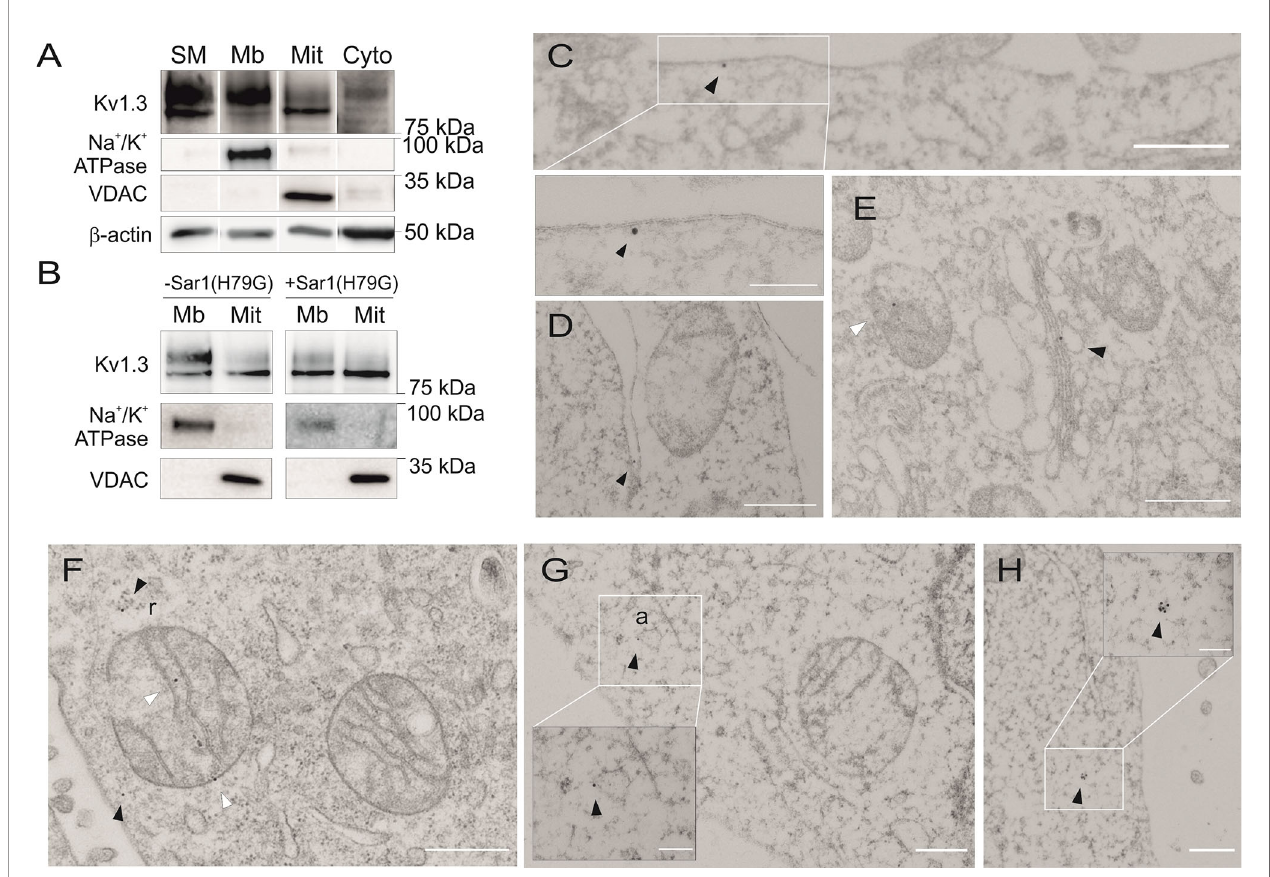
FIGURE 1 | Kv1.3 is targeted to the mitochondria by bypassing the endoplasmic reticulum. (A) Subcellular fractionation to obtain the membranous (Mb), mitochondrial (Mit) and cytosolic (Cyto) fractions of HEK 293 cells transfected with Kv1.3YFP. SM, starting materials. Na + /K + ATPase is used as a plasma membrane (PM) marker, and VDAC is used as a mitochondrial marker. b -actin identi fi ed cytosolic-enriched fractions. Note the difference in molecular weight of Kv1.3 bands from the Mb and Mit fractions. (B) Mb and Mit fractions of HEK 293 cells transfected with Kv1.3YFP were obtained. Cells were cotransfected with (+) or without (-) a constitutively active Sar1(H79G) dominant-negative GTPase. (C – H) Electron micrographs of HEK 293 cells transfected with Kv1.3YFP. Kv1.3 was labeled with 18 nm immunogold particles. Arrowheads indicate Kv1.3. (C) Plasma membrane Kv1.3. (D) Kv1.3 in the ER. (E) Kv1.3 in the Golgi (black arrowhead) and in the IMM (white arrowhead). (F – H) Black arrowheads indicate cytosolic Kv1.3, and white arrowheads indicate mitochondrial Kv1.3. Note the presence of Kv1.3 in ribosomes (r) close to a mitochondrion or embedded in the actin cytoskeleton (a) in (F, G) , respectively. The scale bar indicates 500 nm. White square insets in (C, G, H) highlight higher magni fi cation regions with a scale bar representing 200